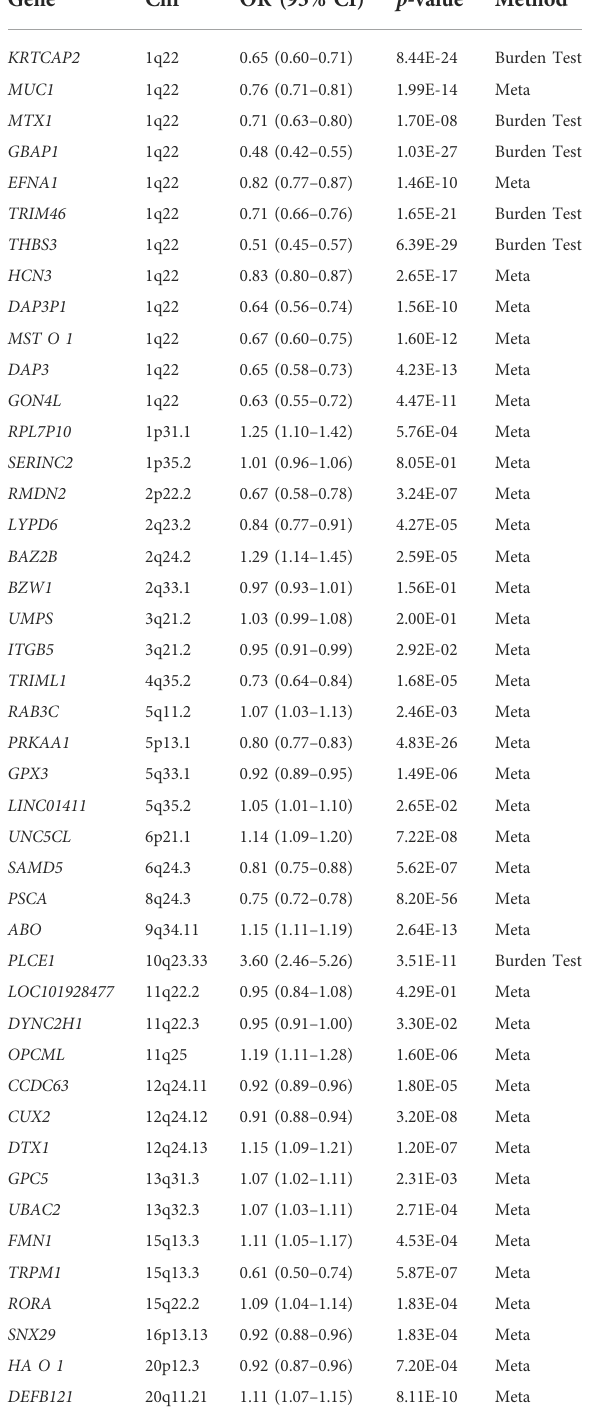
TABLE 1 The results of gene-based analysis for gastric